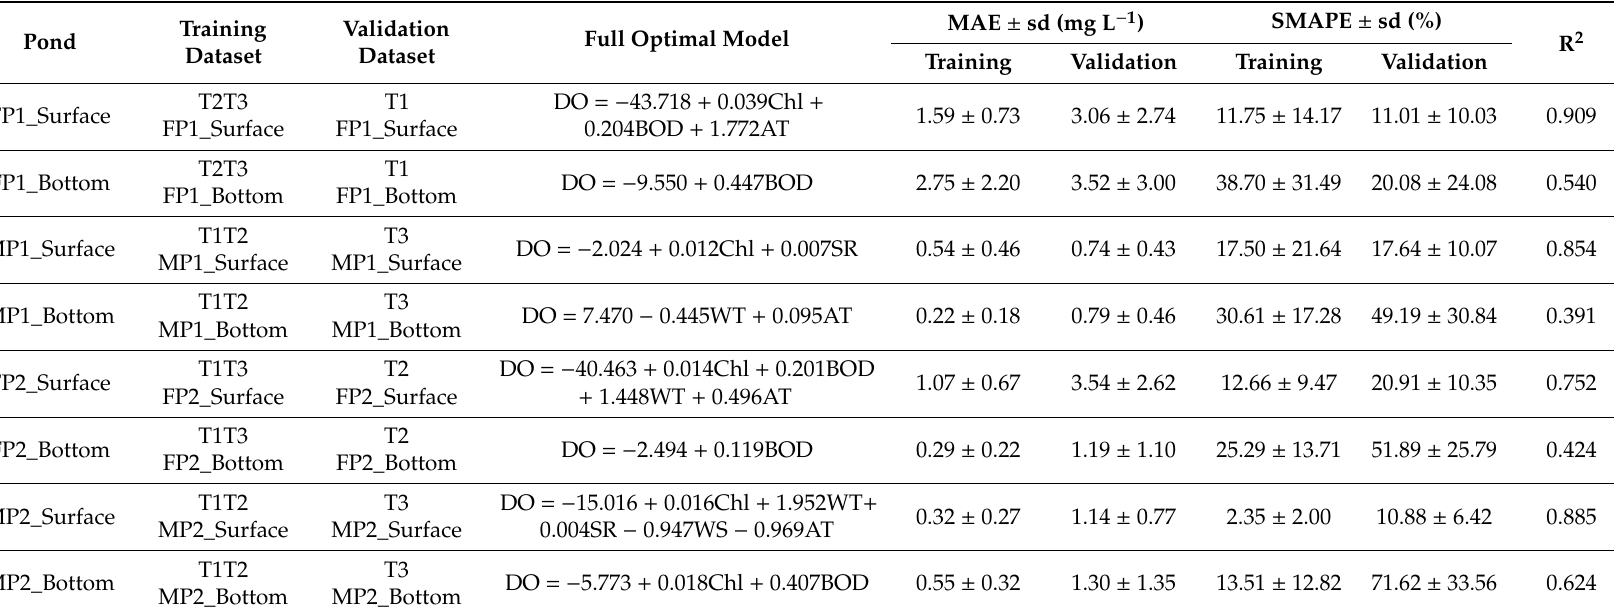
Table 1. Predictive accuracy of the optimal